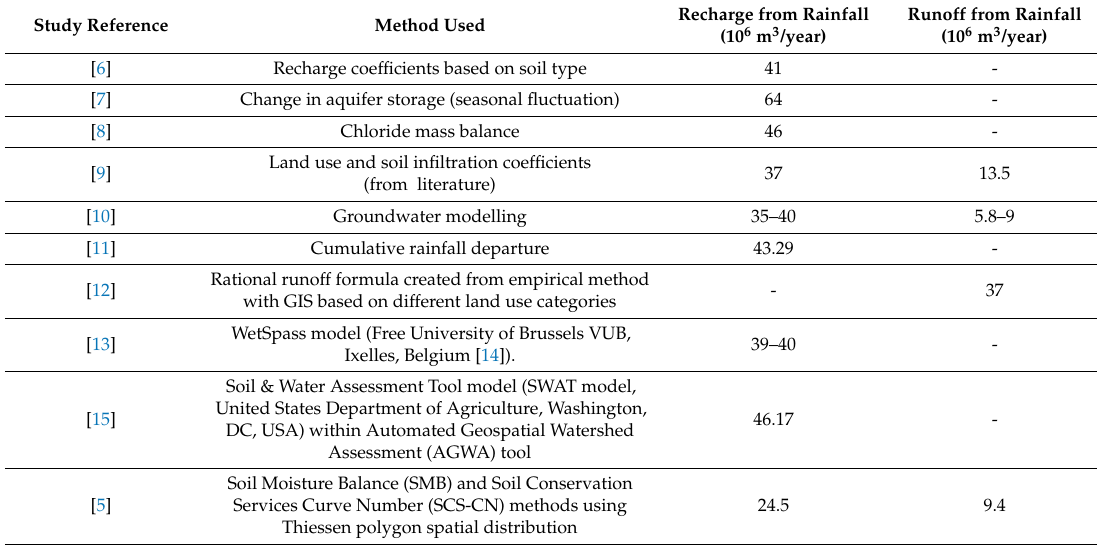
Table 1. Summary of studies carried out to estimate recharge from rainfall for the Gaza Strip *. Study